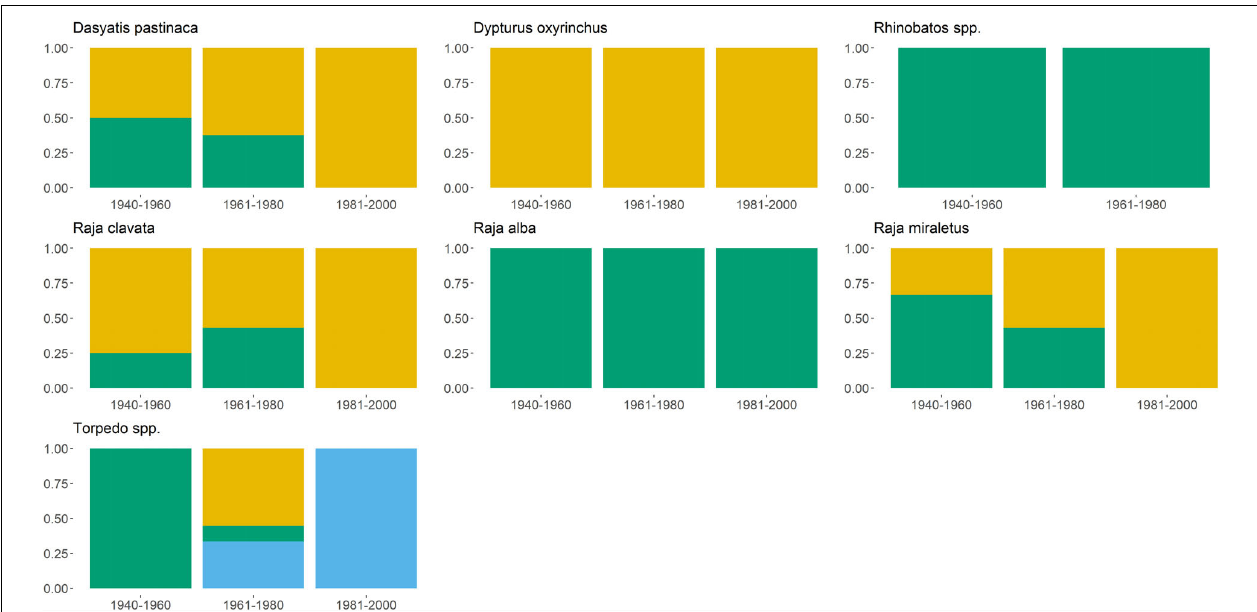
FIGURE 3 | Trends in catches of batoid species. Frequencies in the responses to questions on catches by species/taxa and time period. Color legend: green, much more abundant (three times more); yellow, more abundant (two times more); and pale blue, the same.